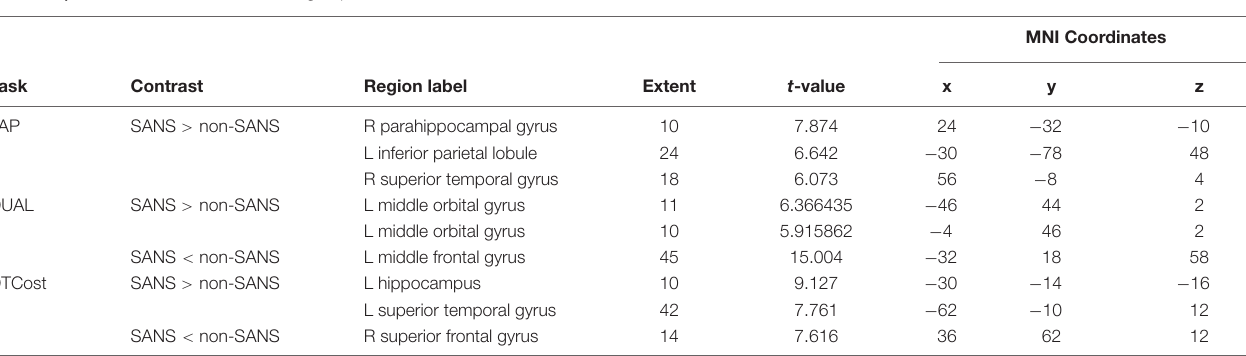
FIGURE 7 | Intercept, slope, and normalized slope differences for the SANS vs. non-SANS cohorts. All areas of change for any task or DTCost. Red, SANS activation > non-SANS activation. Blue, SANS activation < non-SANS activation. (Top) Intercept differences. (Middle) Slope differences. (Bottom) Normalized slope differences. Analyses were conducted at an uncorrected alpha level of p < 0.001. TABLE 4 | SANS vs. non-SANS between-group